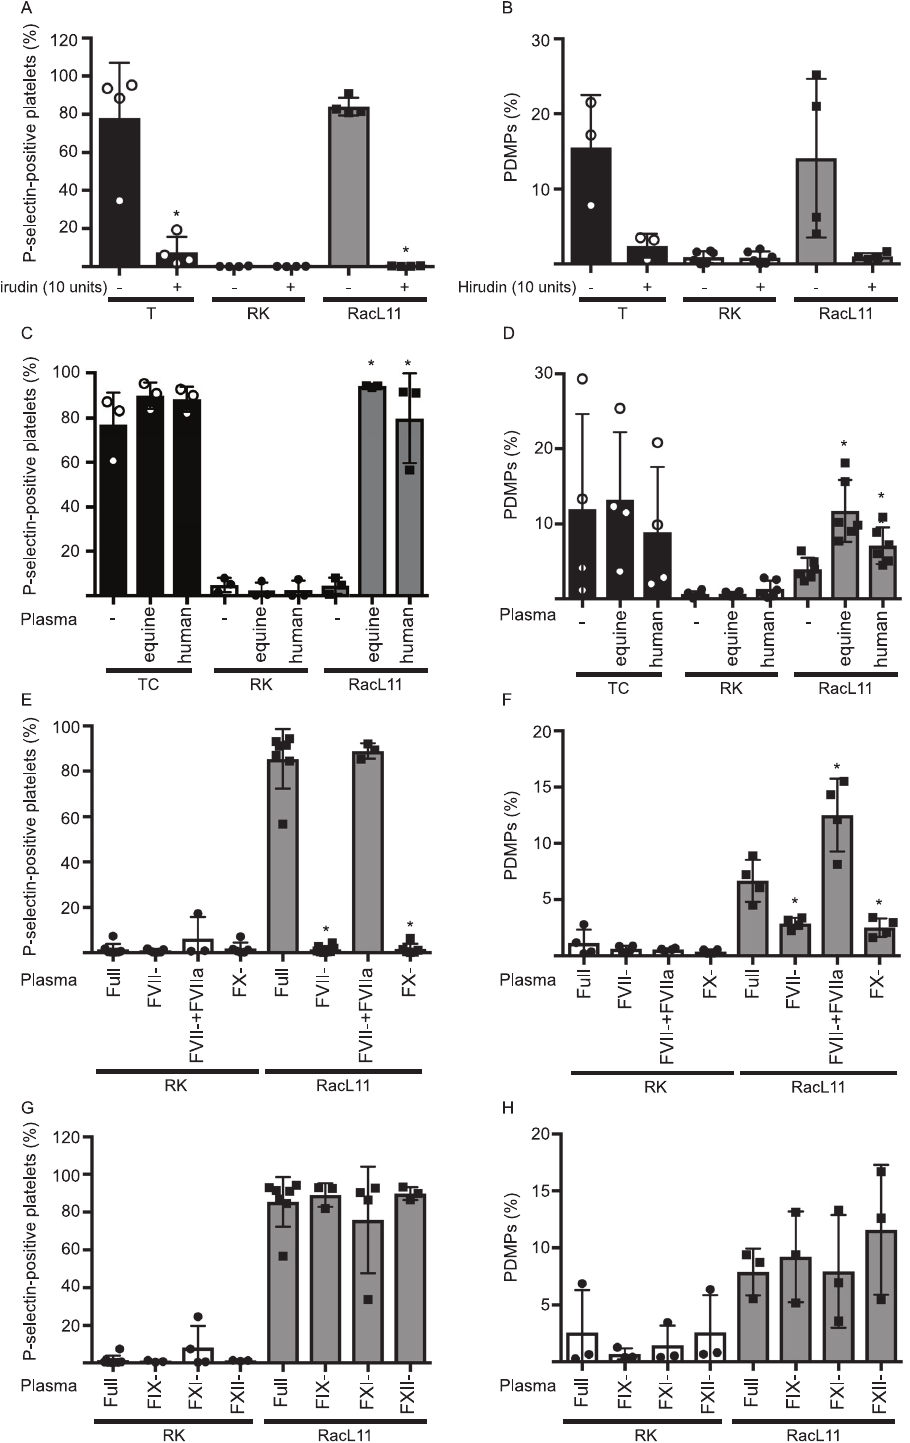
Fig 5. 11-exposed washed platelets. However, supplementation of FVII-deficient MDP with purified human FVIIa (1 nM, FVII- + FVIIa) re-established P-selectin expression induced by RacL11, indicating FX generation was secondary to extrinsic pathway activation ( E , n = 3 to 7). Microvesiculation was also significantly reduced in FVII- and FX- deficient MDP, with supplemental FVIIa boosting the response in FVII-deficient MDP ( F , n = 4). � p < 0.05 versus Full MDP. In contrast, addition of human FIX-, FXI- or FXII-deficient MDP to washed platelets did not significantly affect P selectin expression ( G ) or PDMP release ( H ) (n = 3 to 7). Similar results were seen with Ab4 (S2 Fig).